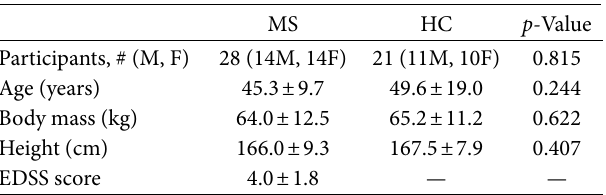
Table 1: Anthropometric and clinical features of the participants. Values are expressed as mean ± standard